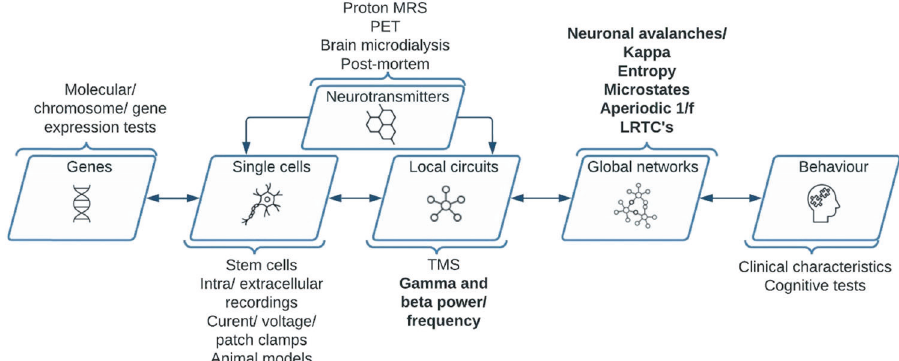
Fig. 1 This fi gure describes the hierarchical levels of neural inference in the brain. Methodologies for probing each level, as well as the EEG markers we describe in this paper, are presented aligned with the biological level that they are hypothesized to capture. We also include bidirectional arrows; for example, local networks may both in fl uence and inherit the activity at global network